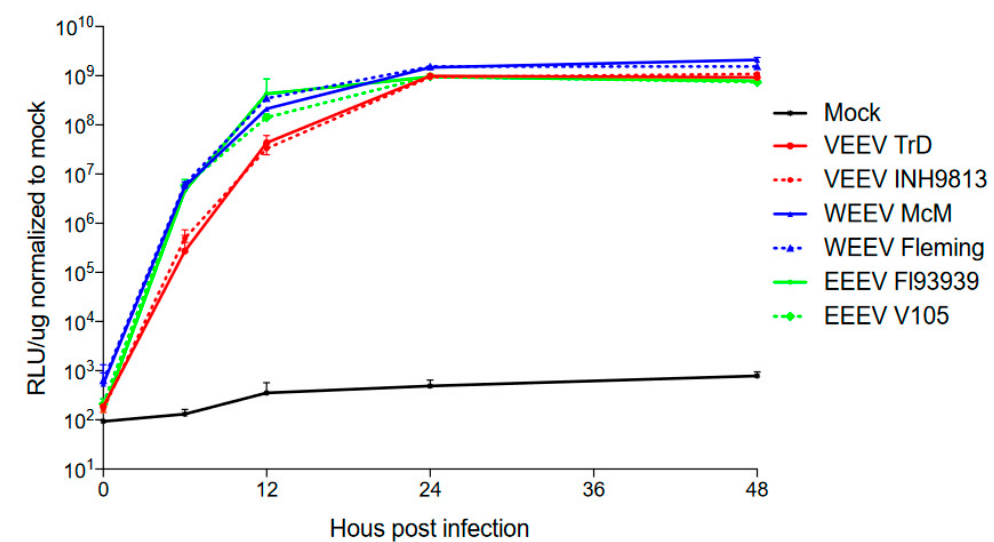
Figure 12. Time course of nanoLuciferase assay results in relative light units/ µ g of protein after infection of BHK cells with vectors derived from each indicated virus. All INH9813 viruses were the K3E “wild type” mutant. The MOI was 0.1 PFU.